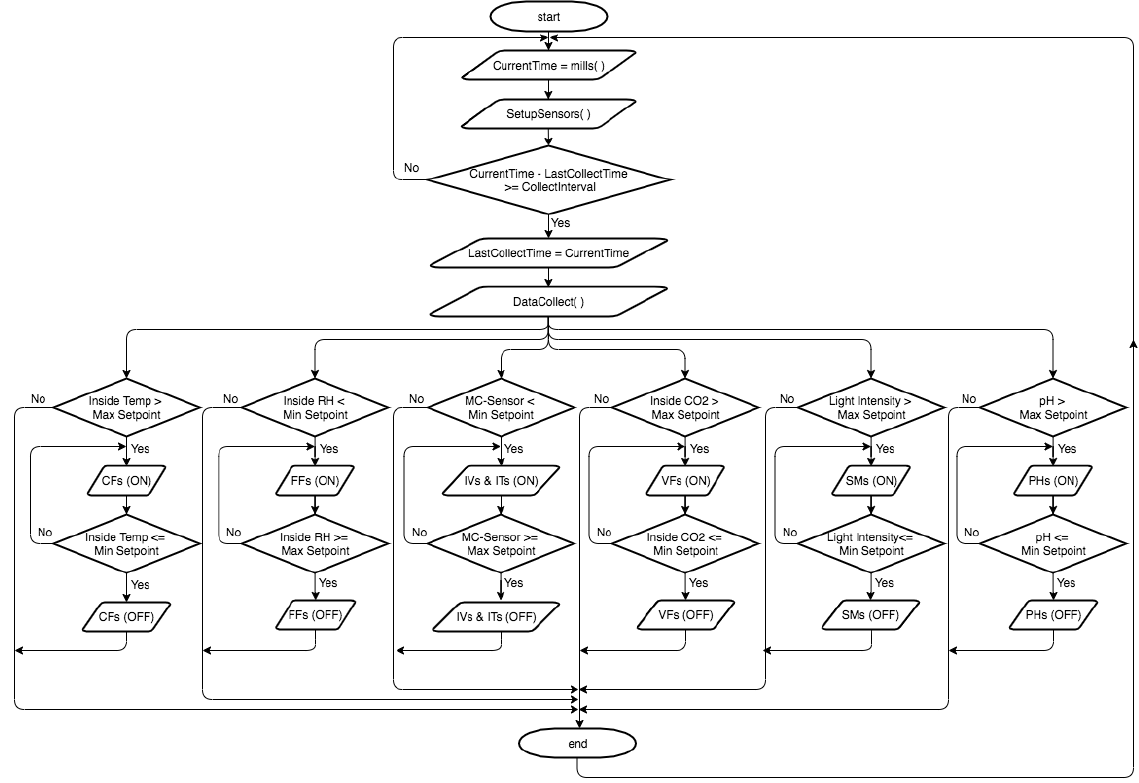
Figure 7. The control structure flowchart for the established cloud-based IoT platform.